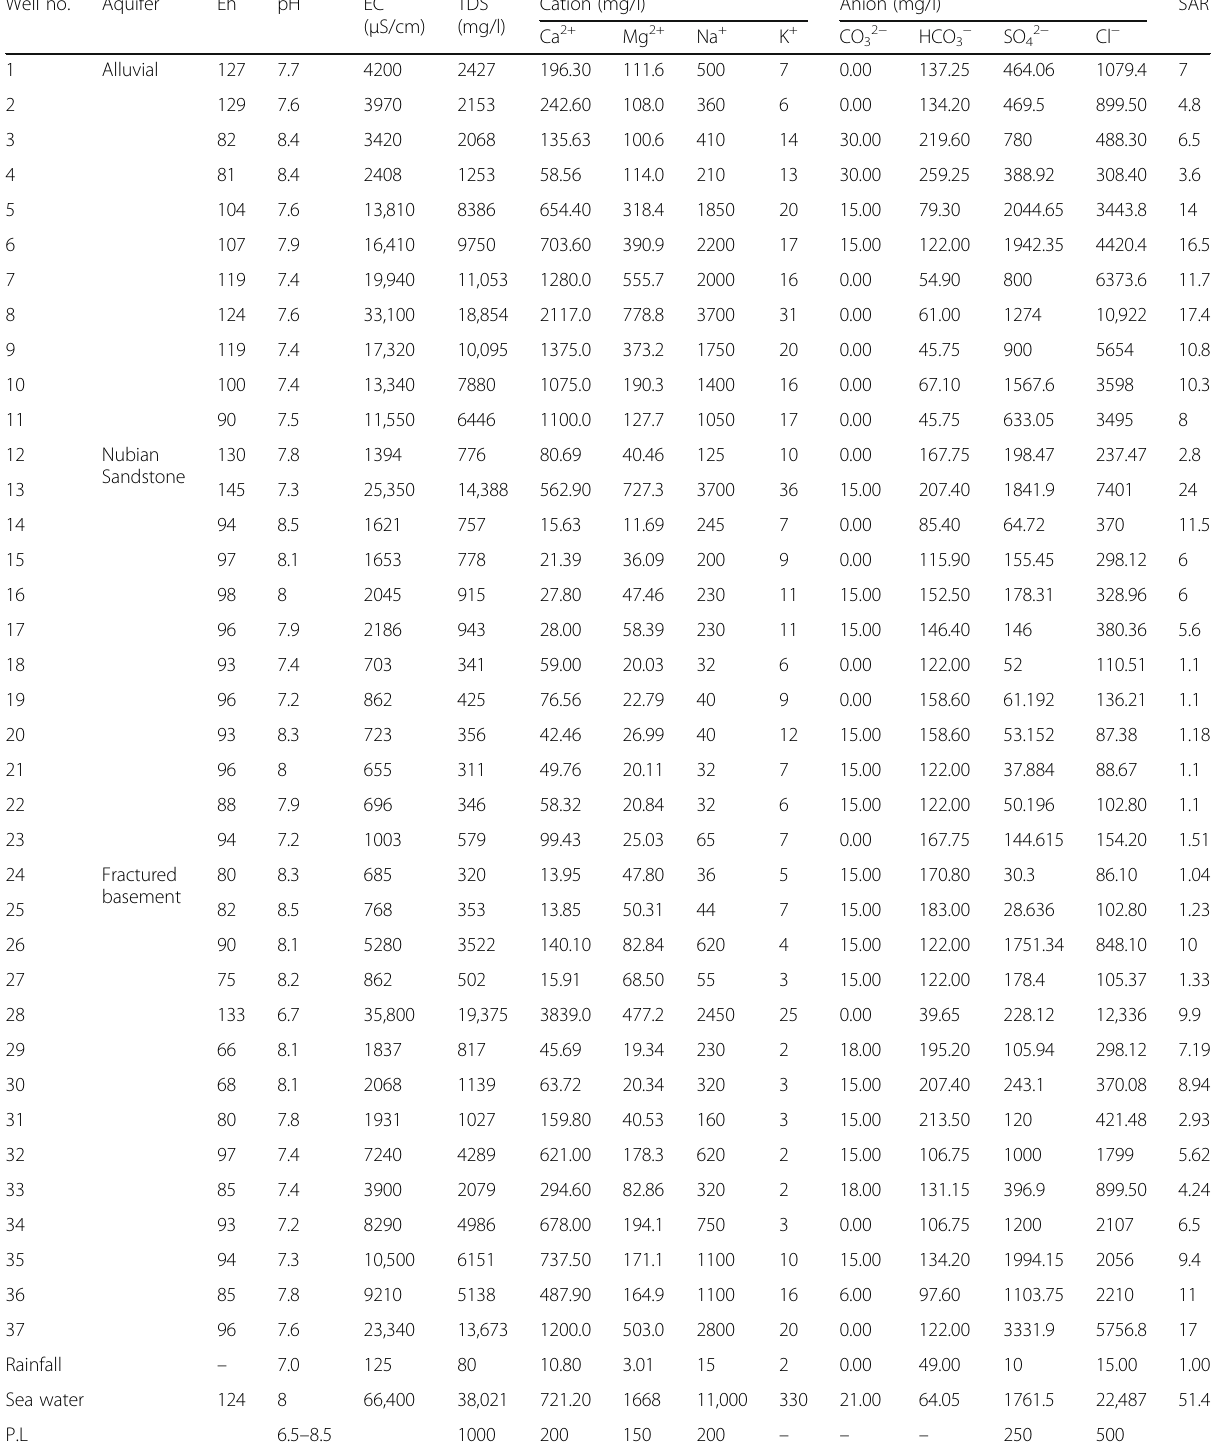
Table 2 Chemical data (major elements) of the investigated groundwater samples Well